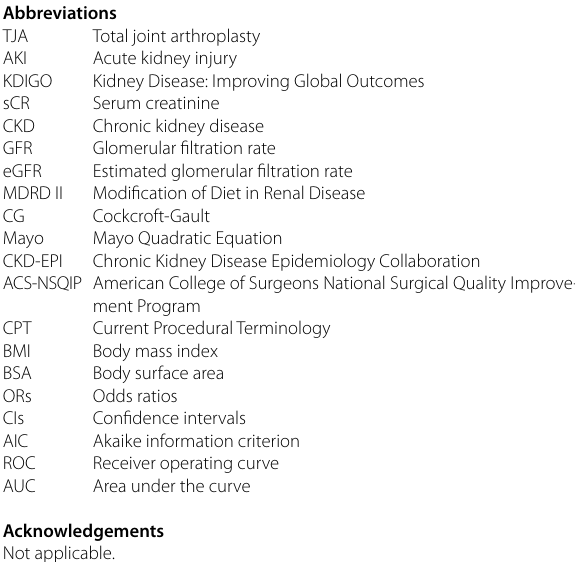
MDRD II: Modification of Diet in Renal Disease, CG: Cockcroft-Gault, Mayo: Mayo Clinic Quadratic, CKD-EPI: Chronic Kidney Disease Epidemiology Collaboration